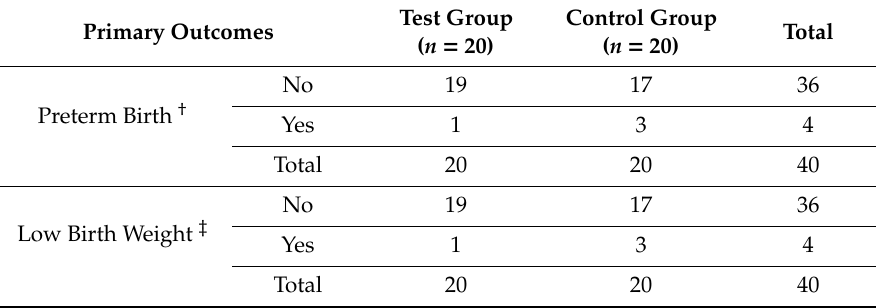
Table 5. Primary outcomes.